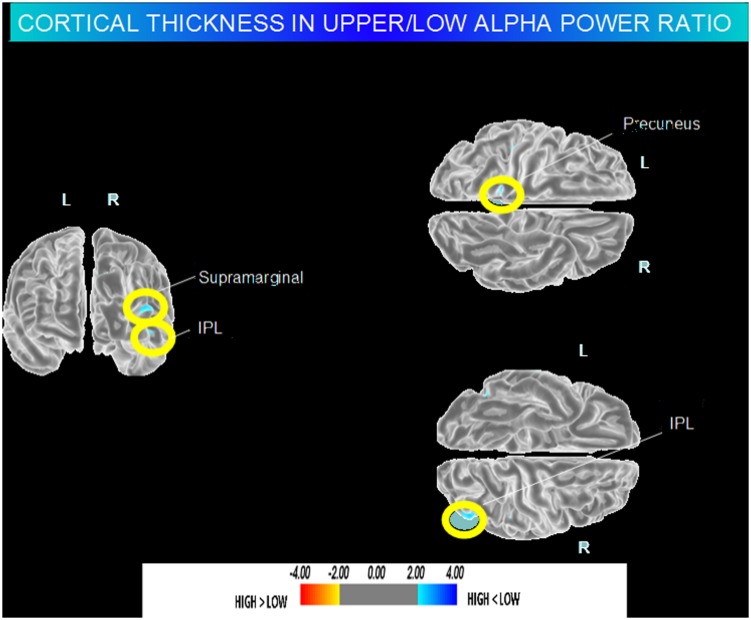
Brain regions with significant regional cortical thickness differences in MCI with high a3/a2 ratio compared to MCI with low averaged with middle a3/a2 ratio (p < 0.01 uncorrected). The color-coding for p values is on a logarithmic scale. Warmer color represents cortical thinning, cooler color represents cortical thickening. Results are presented on the pial cortical surface of brain: dark gray regions represent sulci and light gray regions represent gyri.